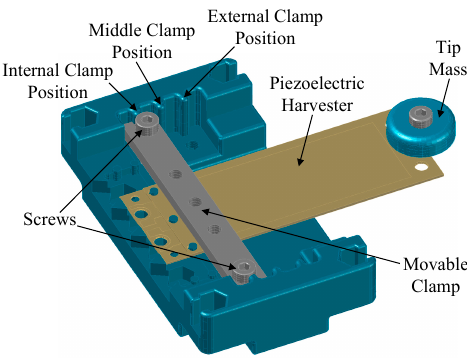
Figure 18. Schematic representation of the commercial resonance frequency tuning kit [35] exploiting a clamp position change based MTT.